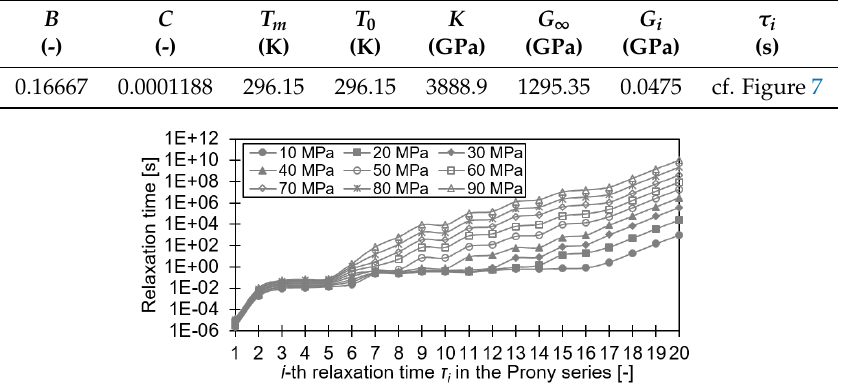
Figure 7. Stress-dependent relaxation times of the Prony series in Equation (2).